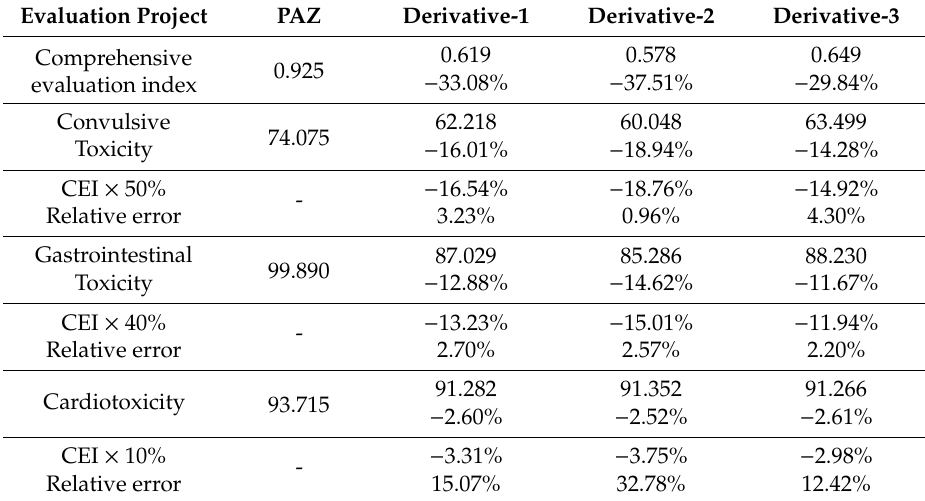
Table6. Contrastivevalidationofsingle-factorandmulti-factoradversedrugreactionsofFQsderivatives. Evaluation